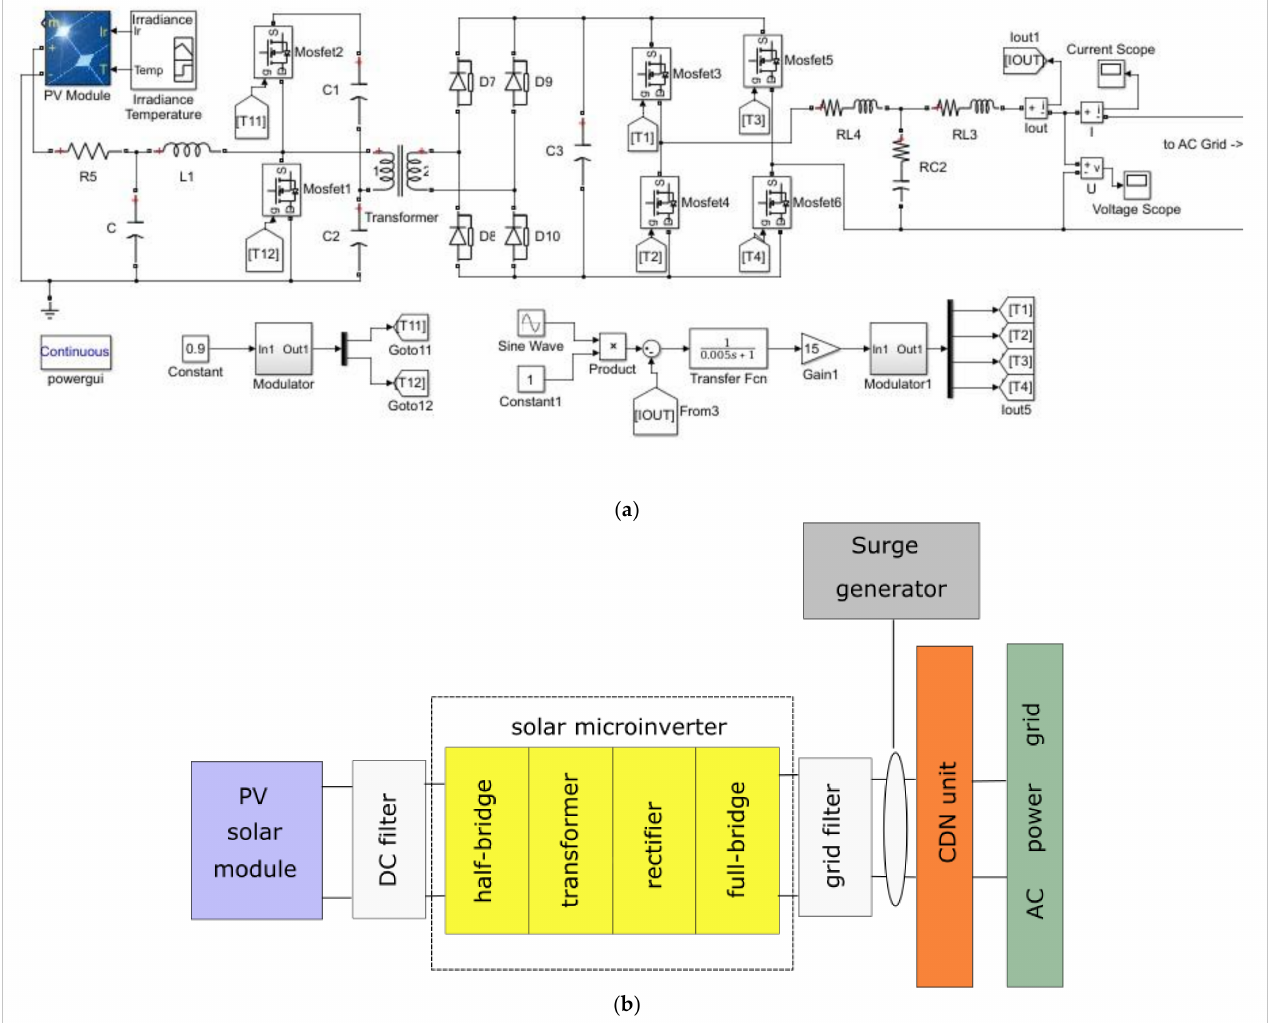
Figure 4. The structure of the tested system consisting of a photovoltaic module with a microinverter: ( a ) Detailed description. ( b ) Block description.